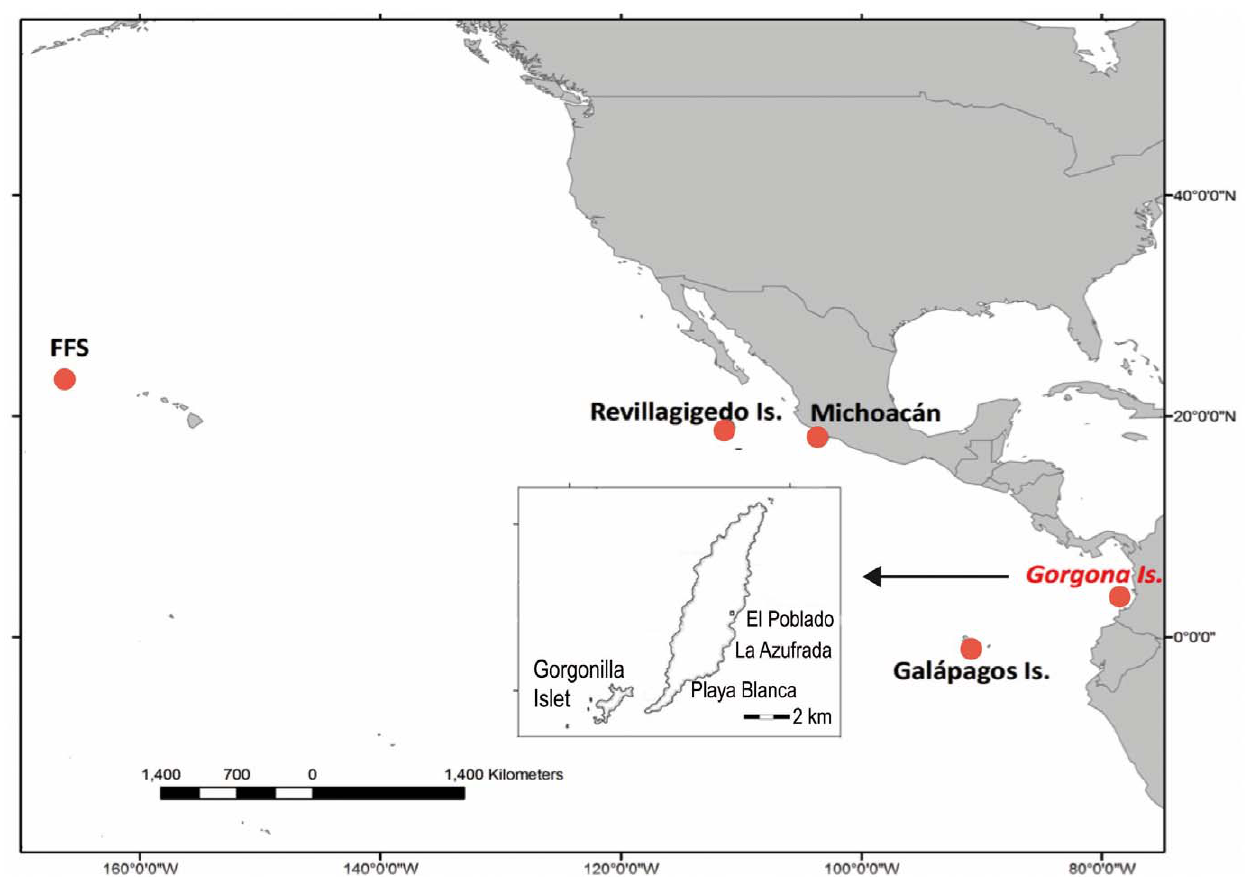
Figure 1. Location of Gorgona National Park in the Pacific. Dots represent locations from where haplotypes were identified, excluding an Australasian hypothetical rookery. Turtles were caught by hand in the coral reefs of La Azufrada and Playa Blanca on the east side of the island.